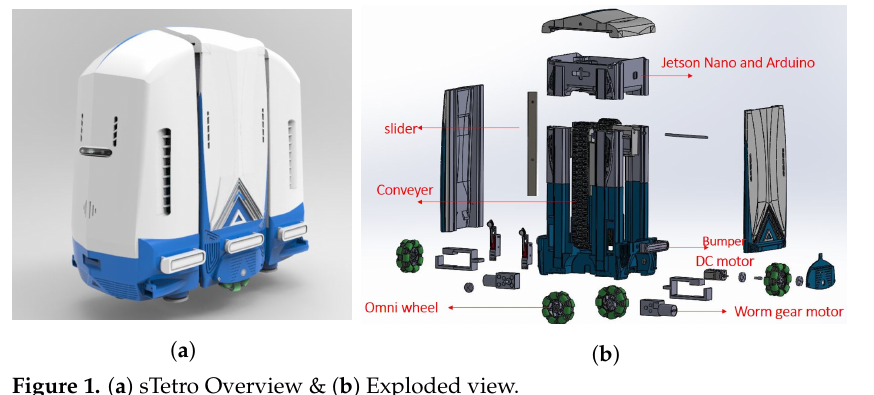
Figure 1. ( a ) sTetro Overview & ( b ) Exploded view.